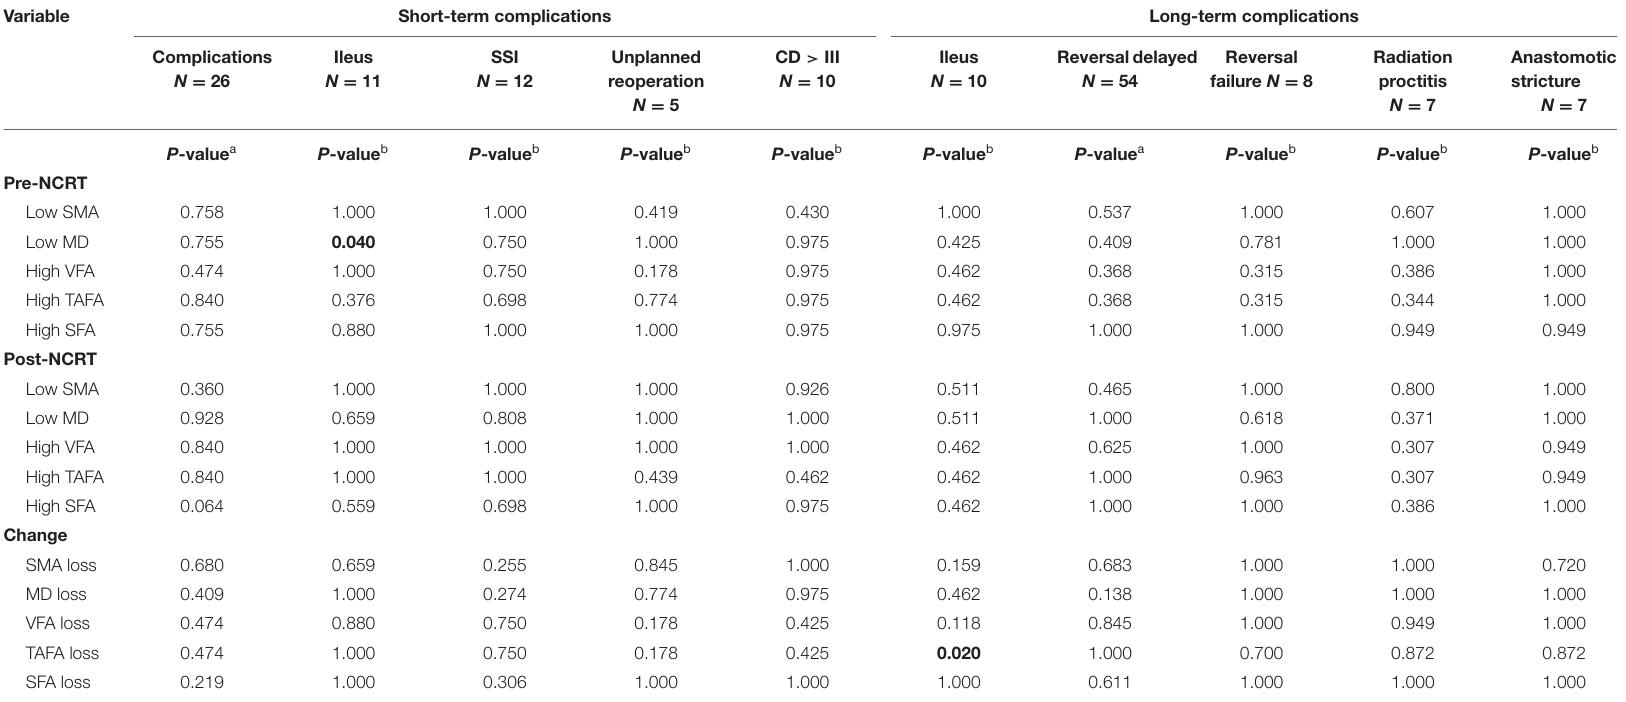
SSI, surgical site infection; CD, Clavien-Dindo classification; SMA, skeletal muscle area; MD, muscle density; VFA, visceral fat area; TAFA, total abdominal fat area; SFA, subcutaneous fat area. a Chi-square test. b Fisher’s exact